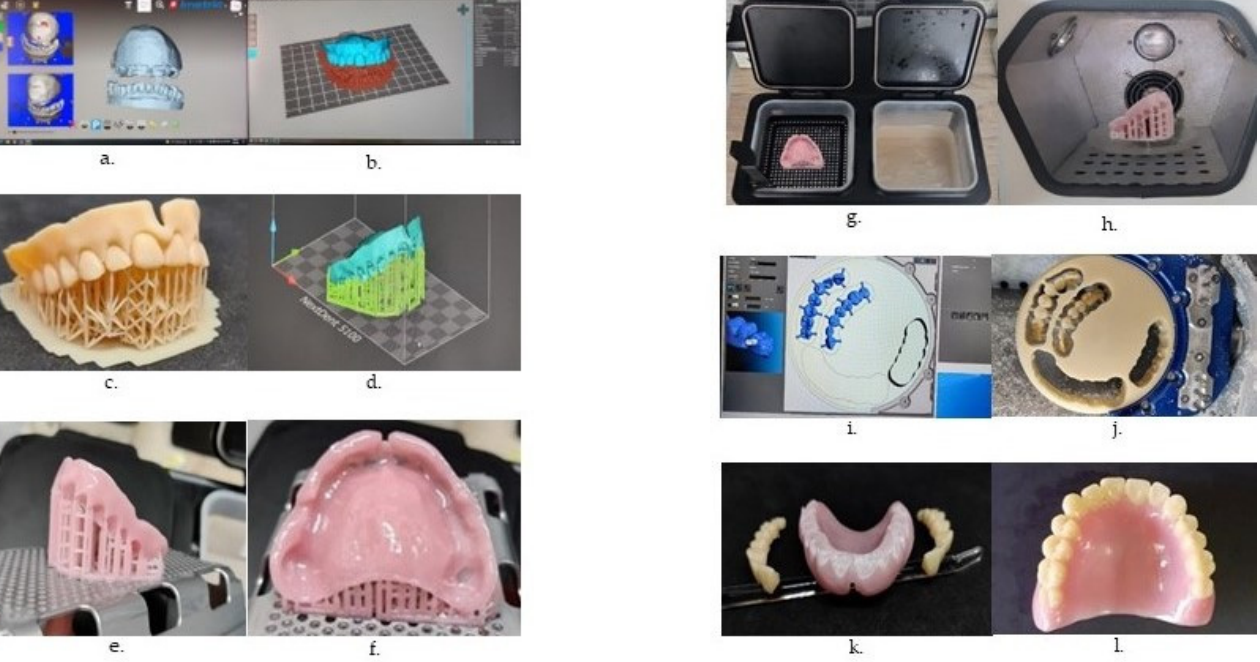
Figure 4. Workflow in 3D printing of a denture base, using vat photo-polymerization. ( a ) Obtaining the virtual model, by scanning; ( b ) digital design of the try-in; ( c ) 3D-printed try-in; ( d ) digital design of the denture base; ( e , f ) 3D-printed denture base; ( g ) cleaning with isopropanol; ( h ) post- polymerization with UV-light; ( i ) fabricating the artificial teeth by CAD/CAM milling; ( j ) attaching the teeth to the denture base; ( k ) polished, ( l ) completed denture.